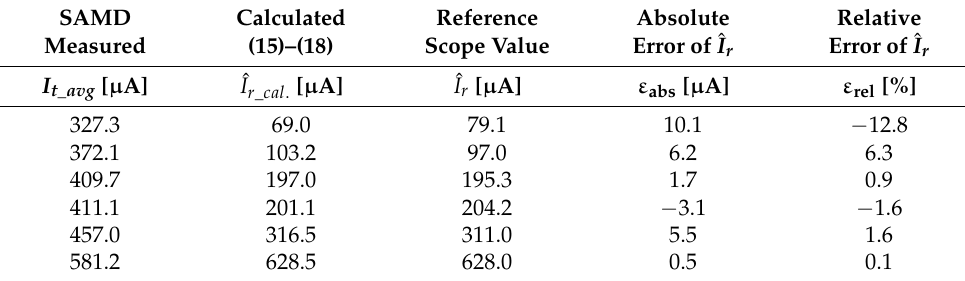
Table 6. Experimental results’